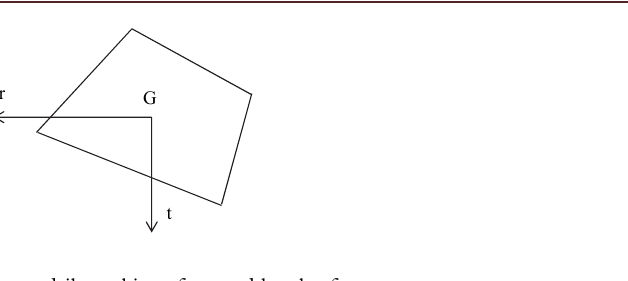
Figure 6: Generic quadrilateral interface and local reference